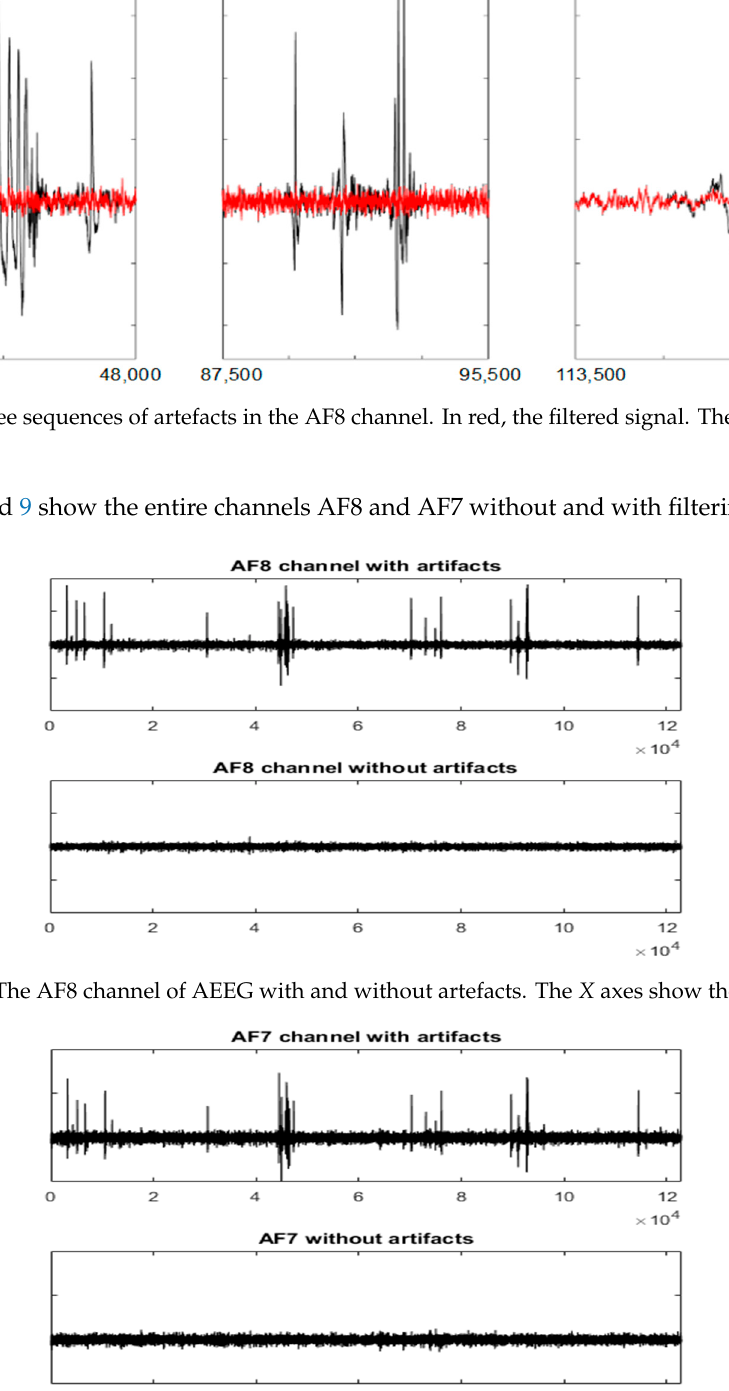
Figure 8. The AF8 channel of AEEG with and without artefacts. The X axes show the samples.